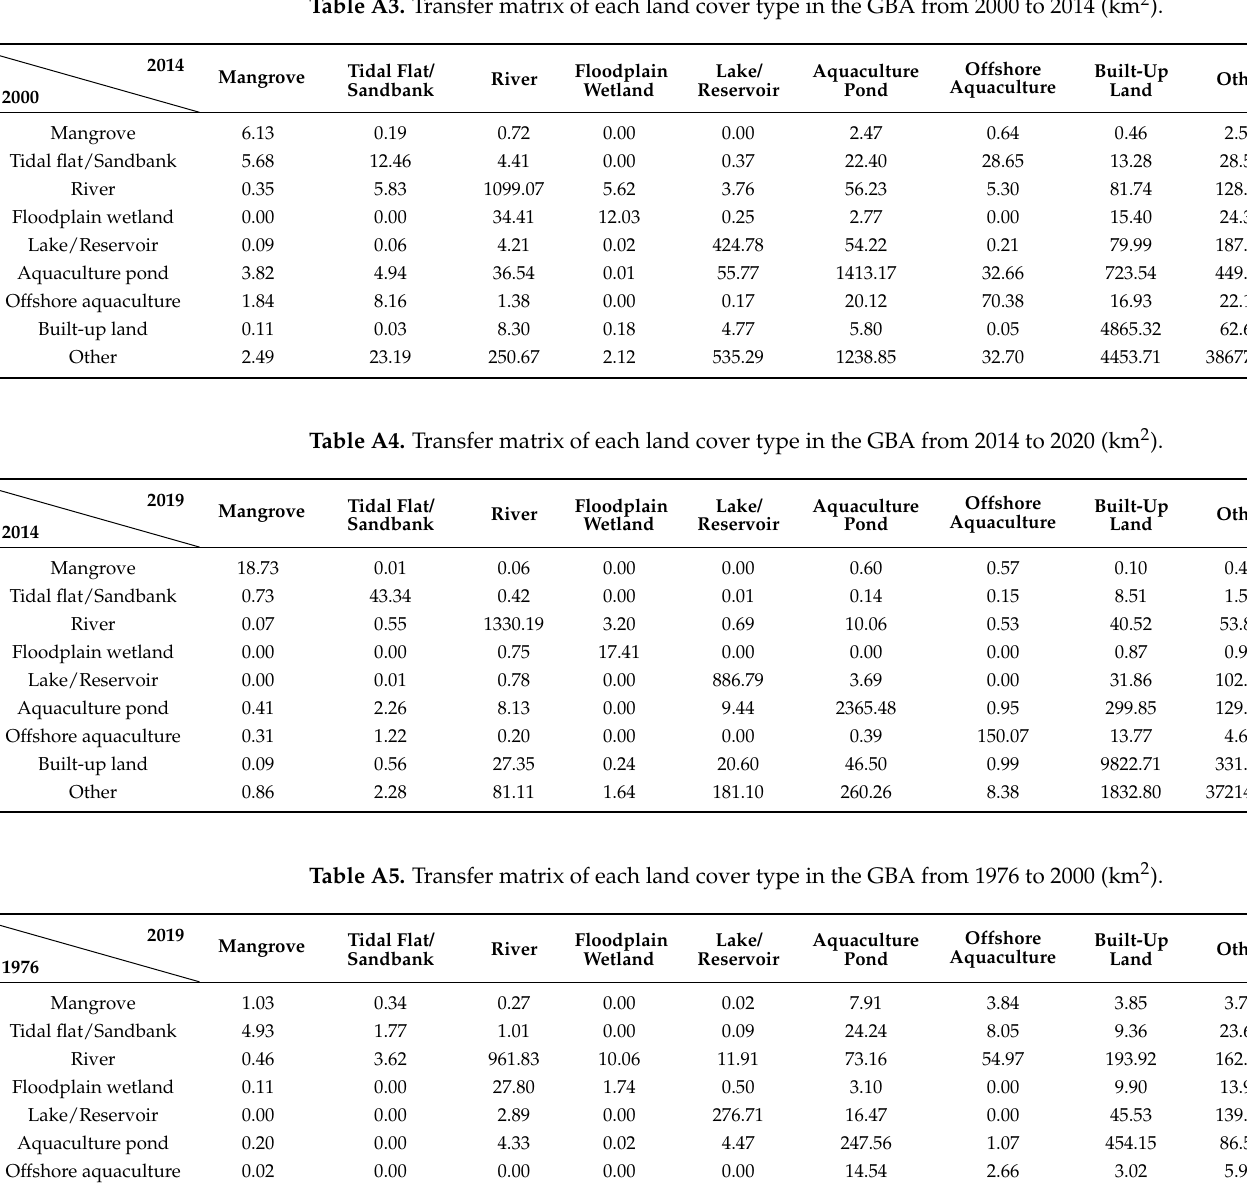
Table A3. Transfer matrix of each land cover type in the GBA from 2000 to 2014 (km 2 ).